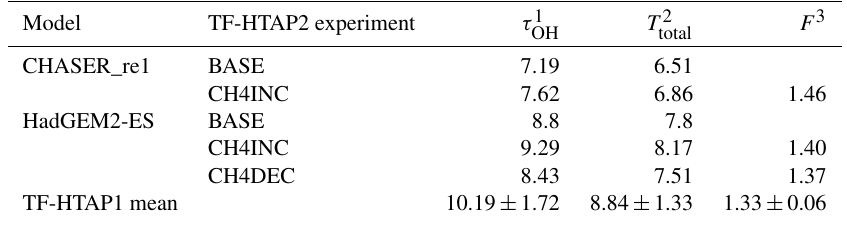
Table 8. Methane lifetime ( τ) and feedback factor in TF-HTAP2 models that provided appropriate data (OH and CH 4